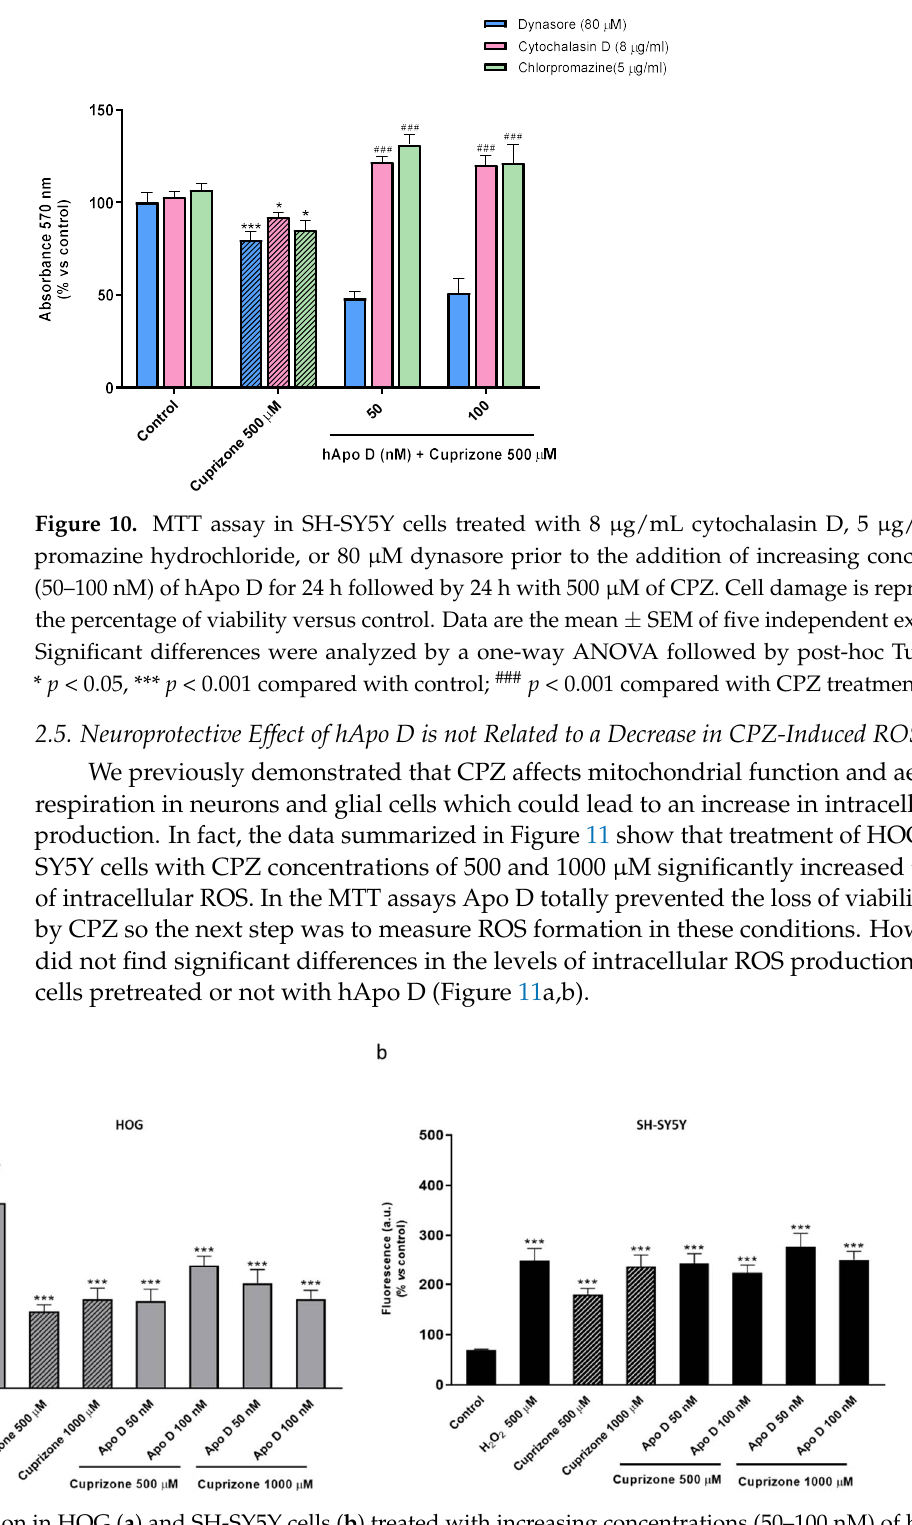
Figure 11. ROS production in HOG ( a ) and SH-SY5Y cells ( b ) treated with increasing concentrations (50–100 nM) of hApo D for 24 h followed by 24 h with 500 or 1000 µ M of CPZ. Changes in ROS levels, measured with the oxidant-sensitive dye H 2 DCFDA, are represented as the percentage of fluorescent DCF production versus control. H 2 O 2 500 µ M was used as positive control. Data are the mean ± SEM of five independent experiments. Significant differences were analyzed by a one-way ANOVA followed by post-hoc Tukey’s test. *** p < 0.001 compared with